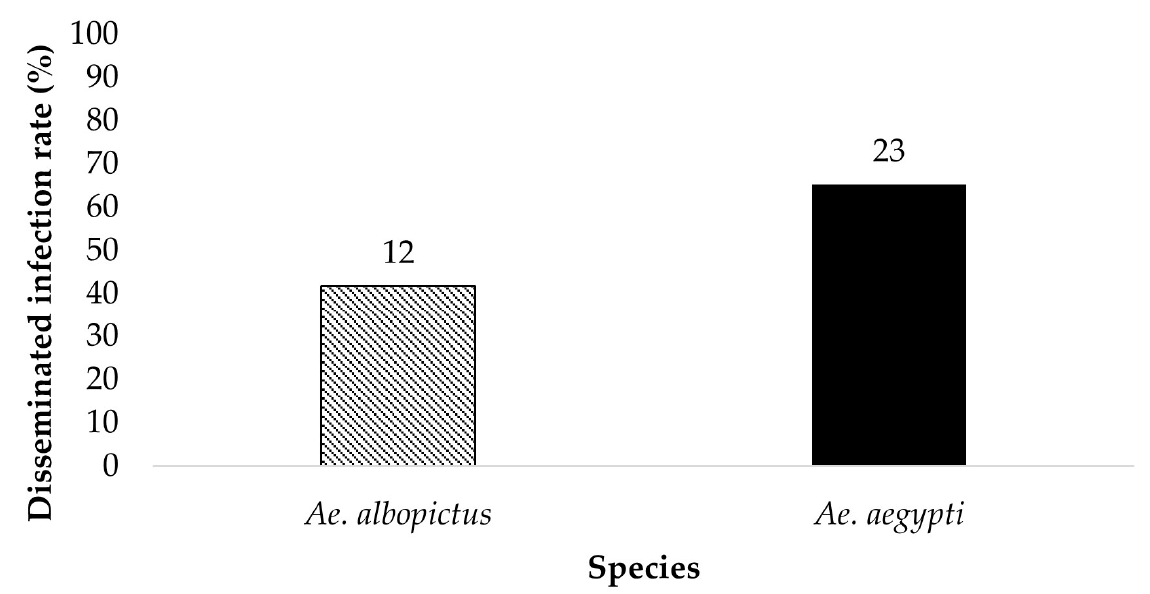
Figure 4. The legs of the ZIKV positive bodies (parents) were tested for the presence of ZIKV. The results show the disseminated infection of ZIKV in Ae. aegypti and Ae. albopictus for the treatment Groups ingesting infected blood at a dose of 7 log 10 PFU/mL. Numbers above the bars represent the number of mosquitoes tested.